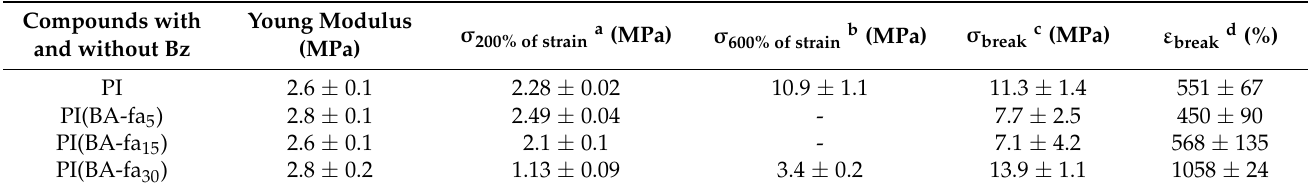
Table A2. Summary of the mechanical properties of the rubber compounds containing BA-fa. Compounds with Young Modulus and without Bz